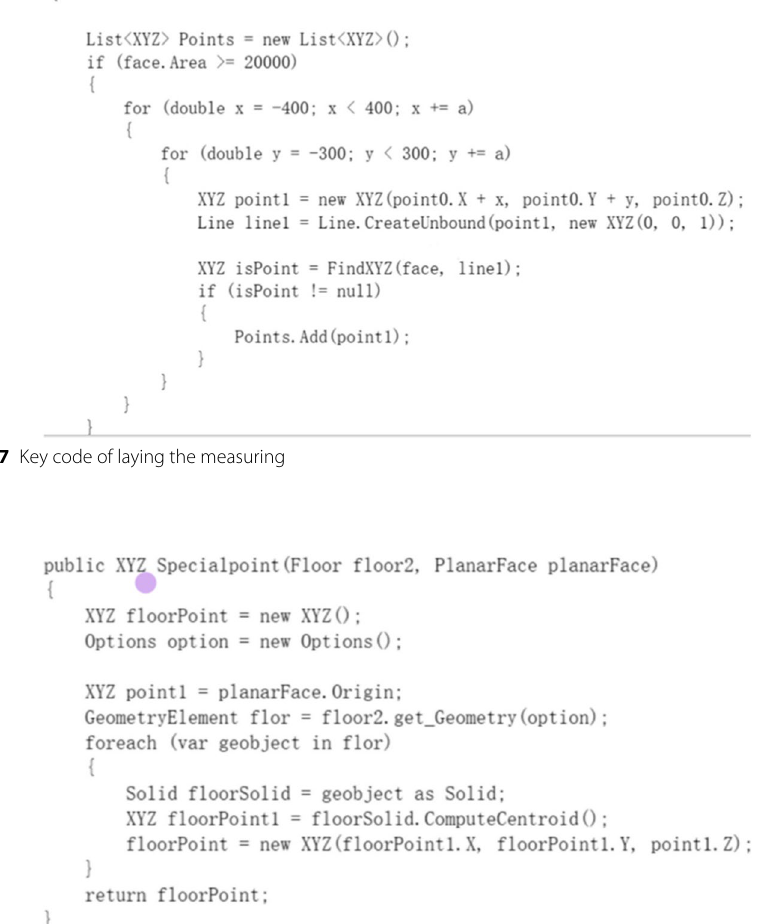
Fig. 8 Key code of getting the floor upper surface shape